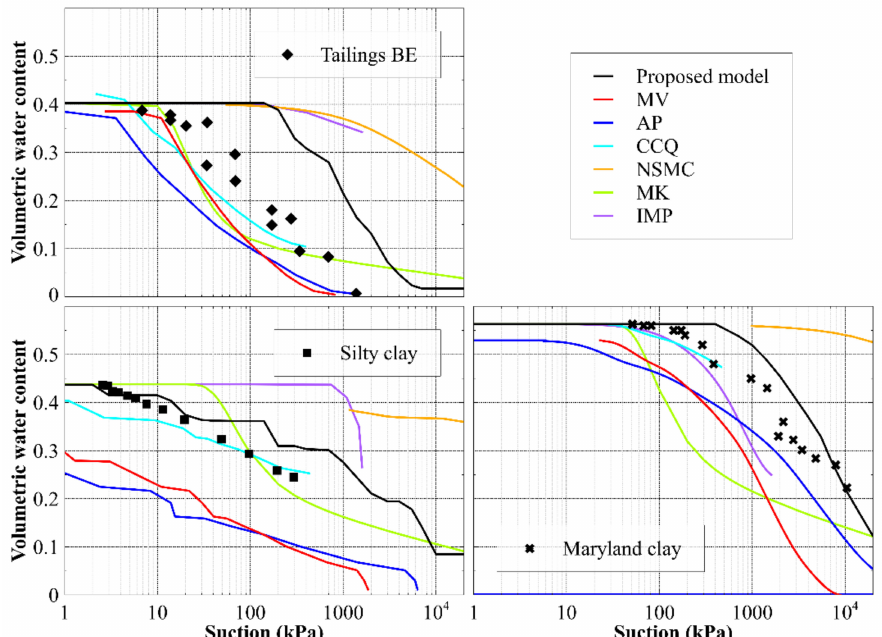
Figure 14. Water retention curve predictions for clays and a tailings from the literature. Predictions from the proposed model and various models from the literature are shown, with water retention curves expressed in terms of volumetric water content vs. suction. Appendix A provides each material’s relevant properties and GSD, and Appendix B states the model parameters